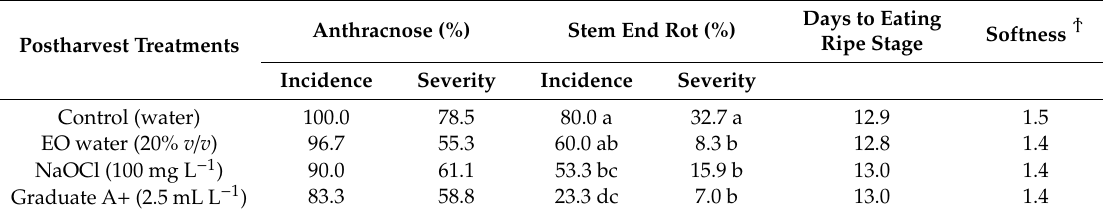
Table 3. Effect of electrolyzed oxidizing (EO) water and synthetic fungicide on anthracnose lesion Table 7. E ff ect of electrolyzed oxidizing (EO) water, synthetic fungicide, and NaOCl on postharvest area and ripening properties of avocado (cv. Hass) after inoculation with Colletotrichum siamense , Trial 2. diseases and ripening properties of avocado (cv. Hass), Trial 4. Table 2. Effect of electrolyzed oxidizing (EO) water and synthetic fungicides on postharvest diseases and ripening properties of avocado cv. Hass, Trial Within each column, means followed by the same letter do not differ significantly at the 5% level of probability according to LSD post hoc test. n = 4 replicates of 10 fruit per replicate. Ϯ indicates mm deformation upon 500 g weight applied on fruit at eating ripe stage for 30 s.